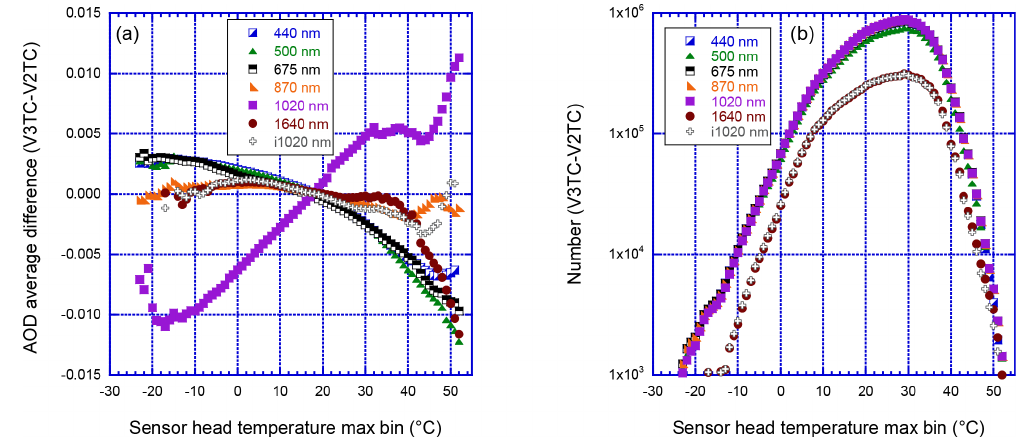
Figure 18. Difference in AOD response between Version 3 and Version 2 temperature correction applied to Version 3 AOD data based on the sensor head temperature from 1993 to 2018. The Version 2 temperature correction assumes temperature ranges for 1020nm and no temperature correction for all other wavelengths, while Version 3 temperature correction characterizes the temperature response for each filter or set of default filters for each instrument for wavelengths ≥ 400nm. (a) The AOD average difference plotted for each 1 ◦ C temperature bin from − 25 to + 55 ◦ C. The AOD at 1020nm exhibits an opposite trend compared to the other wavelengths varying from − 0 . 01 at low temperatures to up to + 0 . 01 at high temperatures. Other wavelengths have slight differences at cold temperatures but apparent dependencies at high temperatures greater than 40 ◦ C possibly due to extrapolation of the temperature coefficients to higher temperatures. (b) The number of measurements plotted for each 1 ◦ C temperature bin with a minimum of 1000 observations.